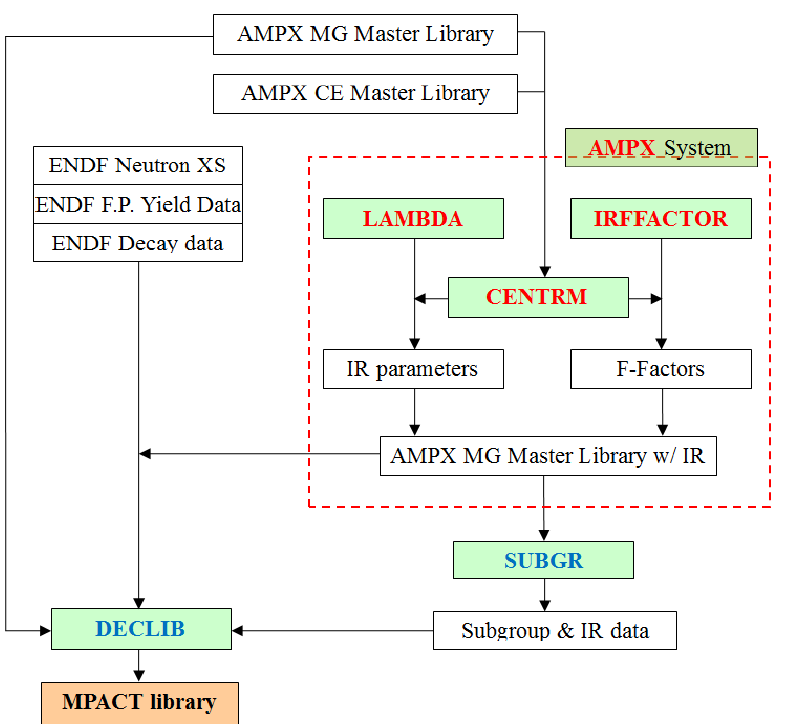
Figure 2. Flow chart to generate the MPACT MG